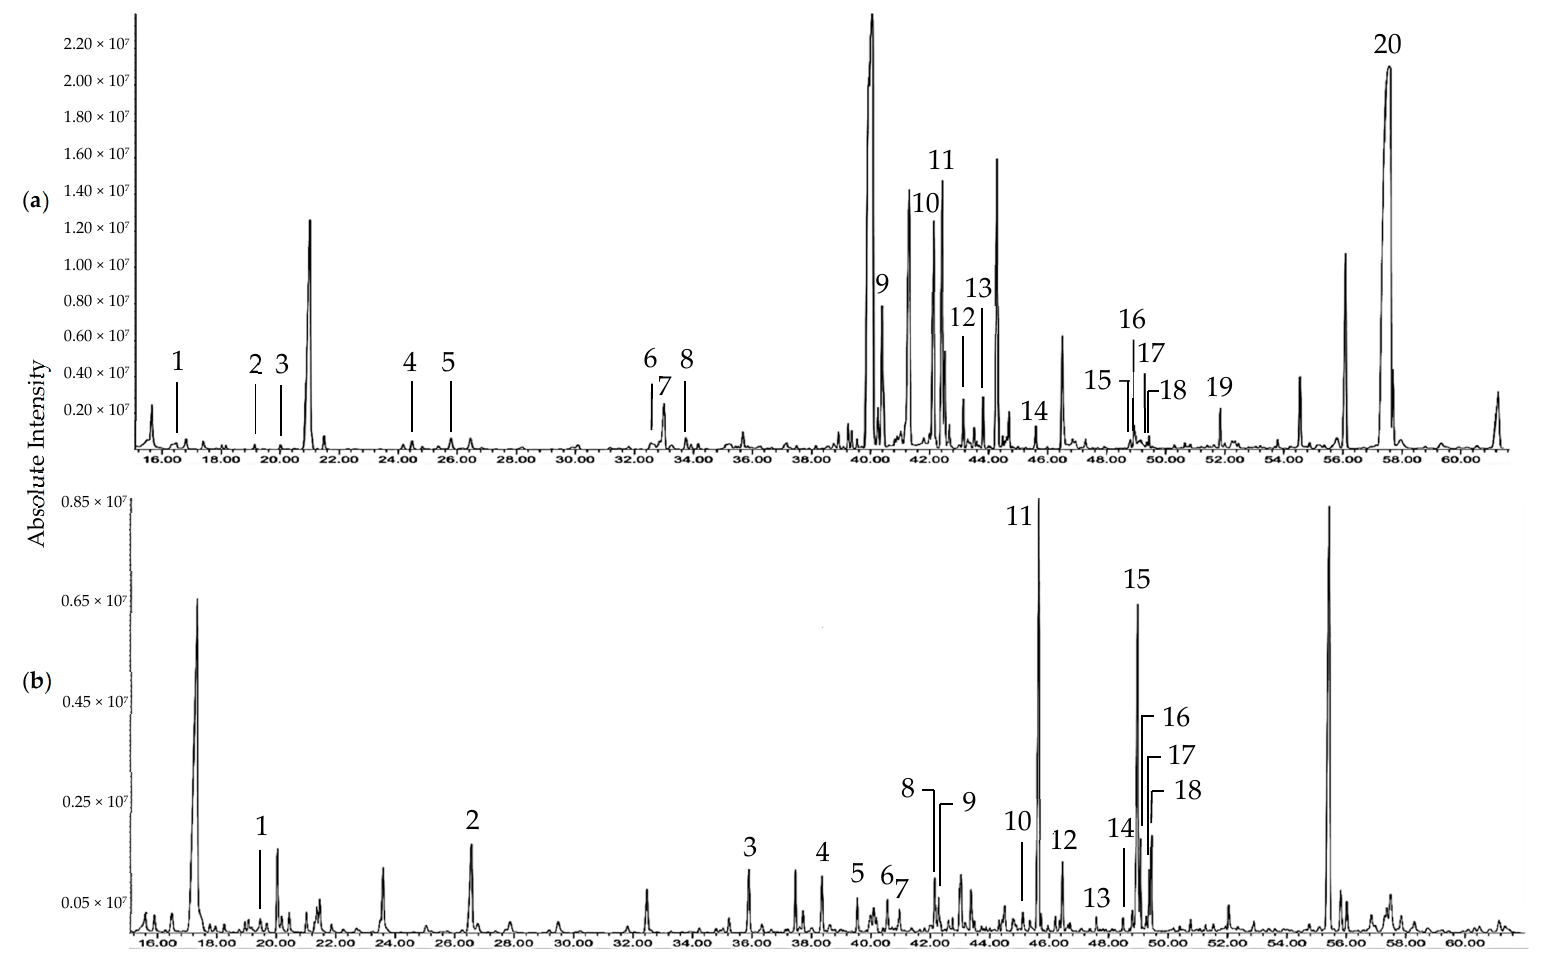
Figure 1. Total ion current (TIC) chromatograms of the trimethylsilyl (TMS)-derivatized D. indum seed methanol fraction (SMF) ( a ) and exocarp dichloromethane fraction (EDF) ( b ). Peak numbers refer to metabolites listed in Tables 3 and 4.